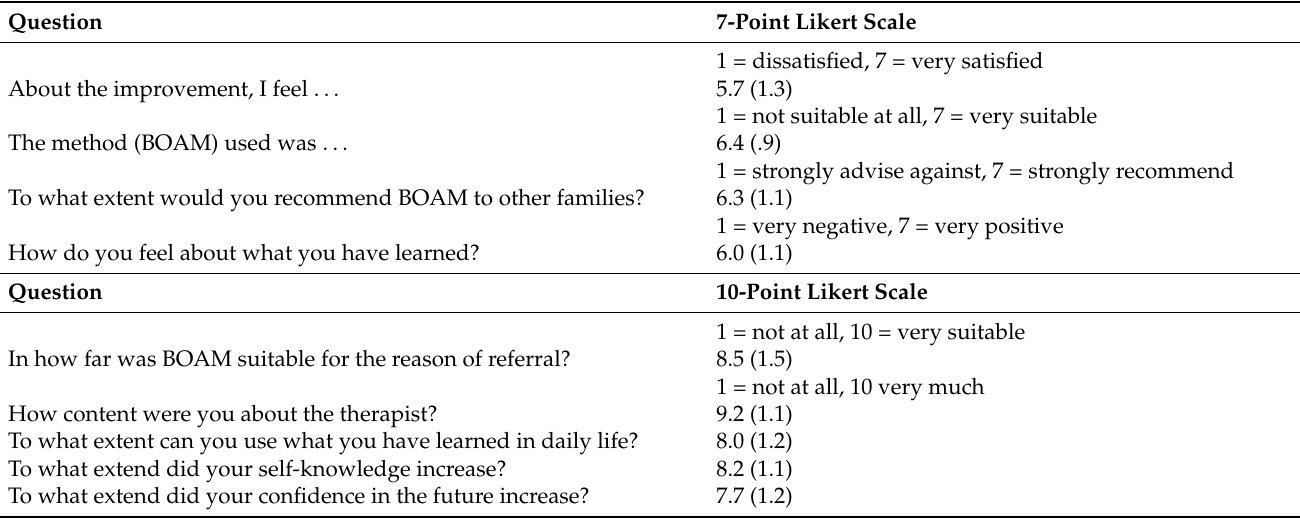
Table 1. Evaluation of the BOAM diagnostic trajectory and subsequent treatment ( n =